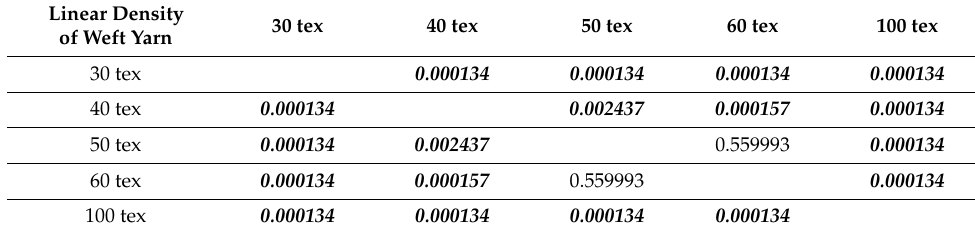
Table 12. The results of the Tukey’s test for the SSB. Linear Density of Weft Yarn